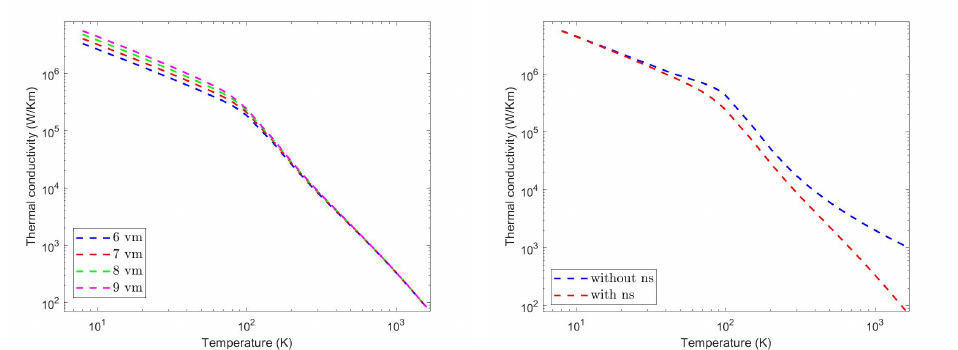
Figure 17. ( Left ): The steady-state conductivity for bulk graphene (without es scattering), obtained by using different numbers of vector moments (vm). ( Right ): with and without normal scattering. = 0.011%. = 0.989%, f The fractions of C 12 and C 13 are f C C 13 12